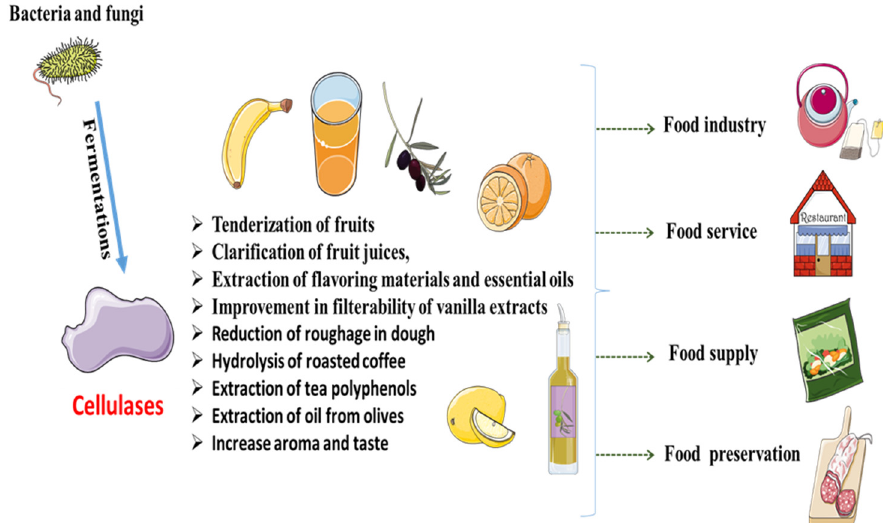
Figure 1. Cellulases application in food industry.